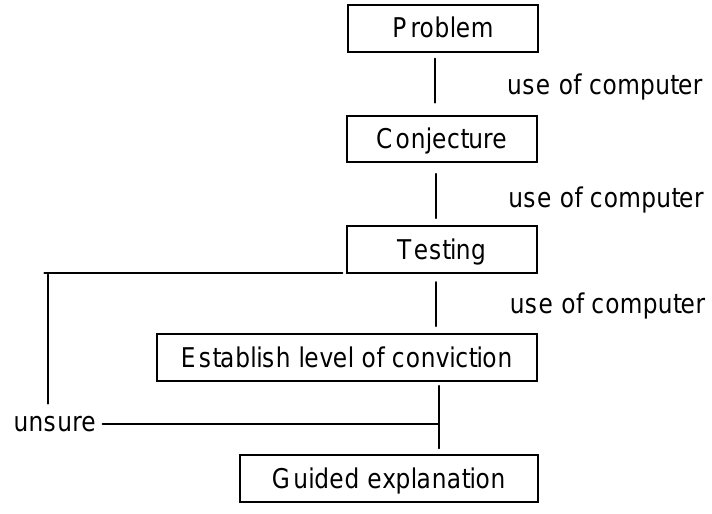
Figure 1. Flow diagram illustrating the process of experimental mathematics using computer